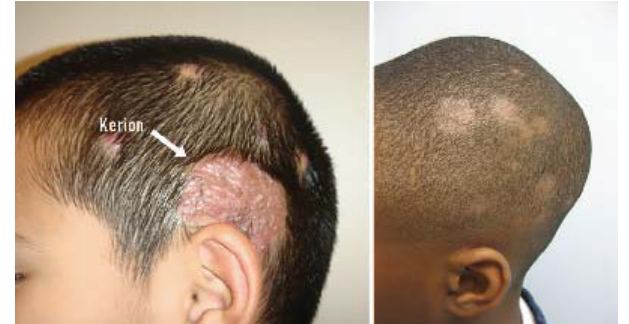
Figure 18. Tinea capitis.